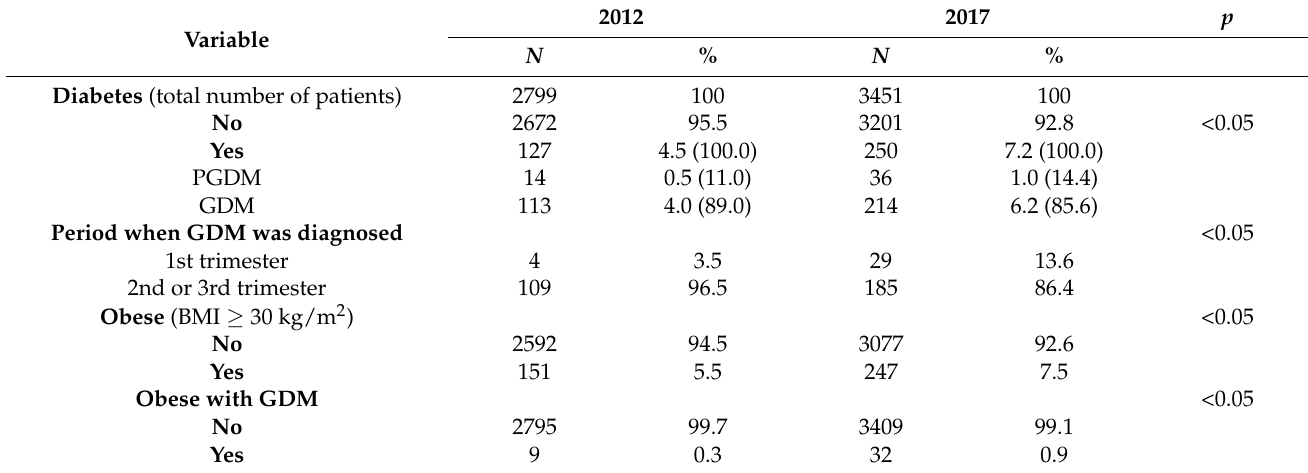
Table 2. The distribution of diabetes mellitus and obesity in Polish pregnant women in years 2012 and 2017 (the numbers in brackets refer to the percentage of GDM/PGDM subtypes in all patients diagnosed with diabetes mellitus). Variable